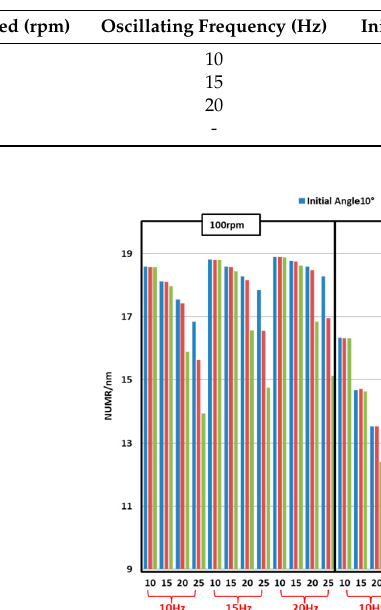
Table 3. Processing parameters.